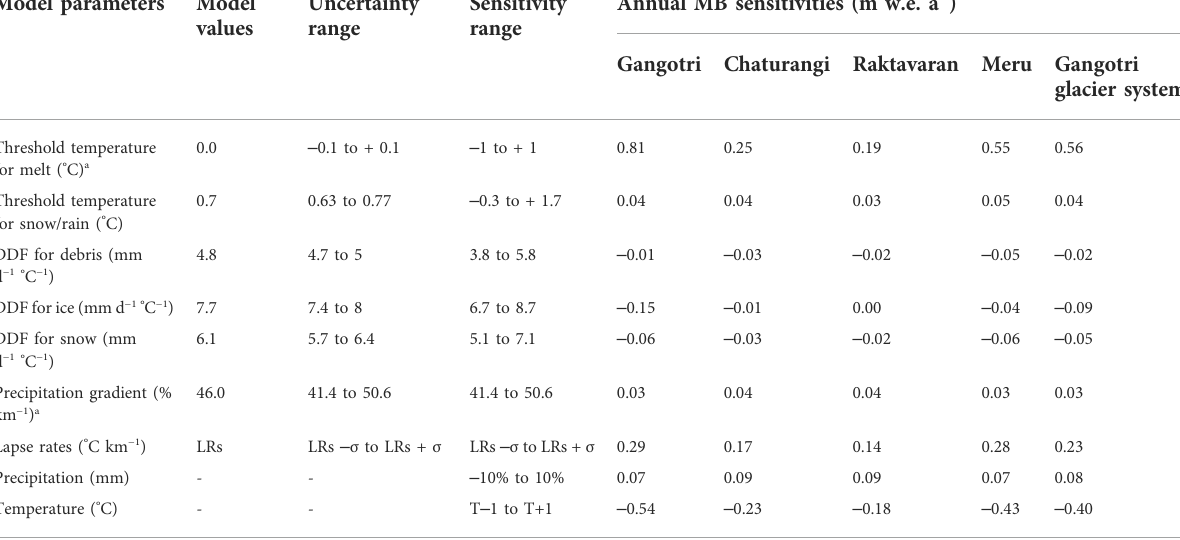
TABLE 2 List of model parameters and range of parameters used for uncertainties and sensitivities of MB. Model